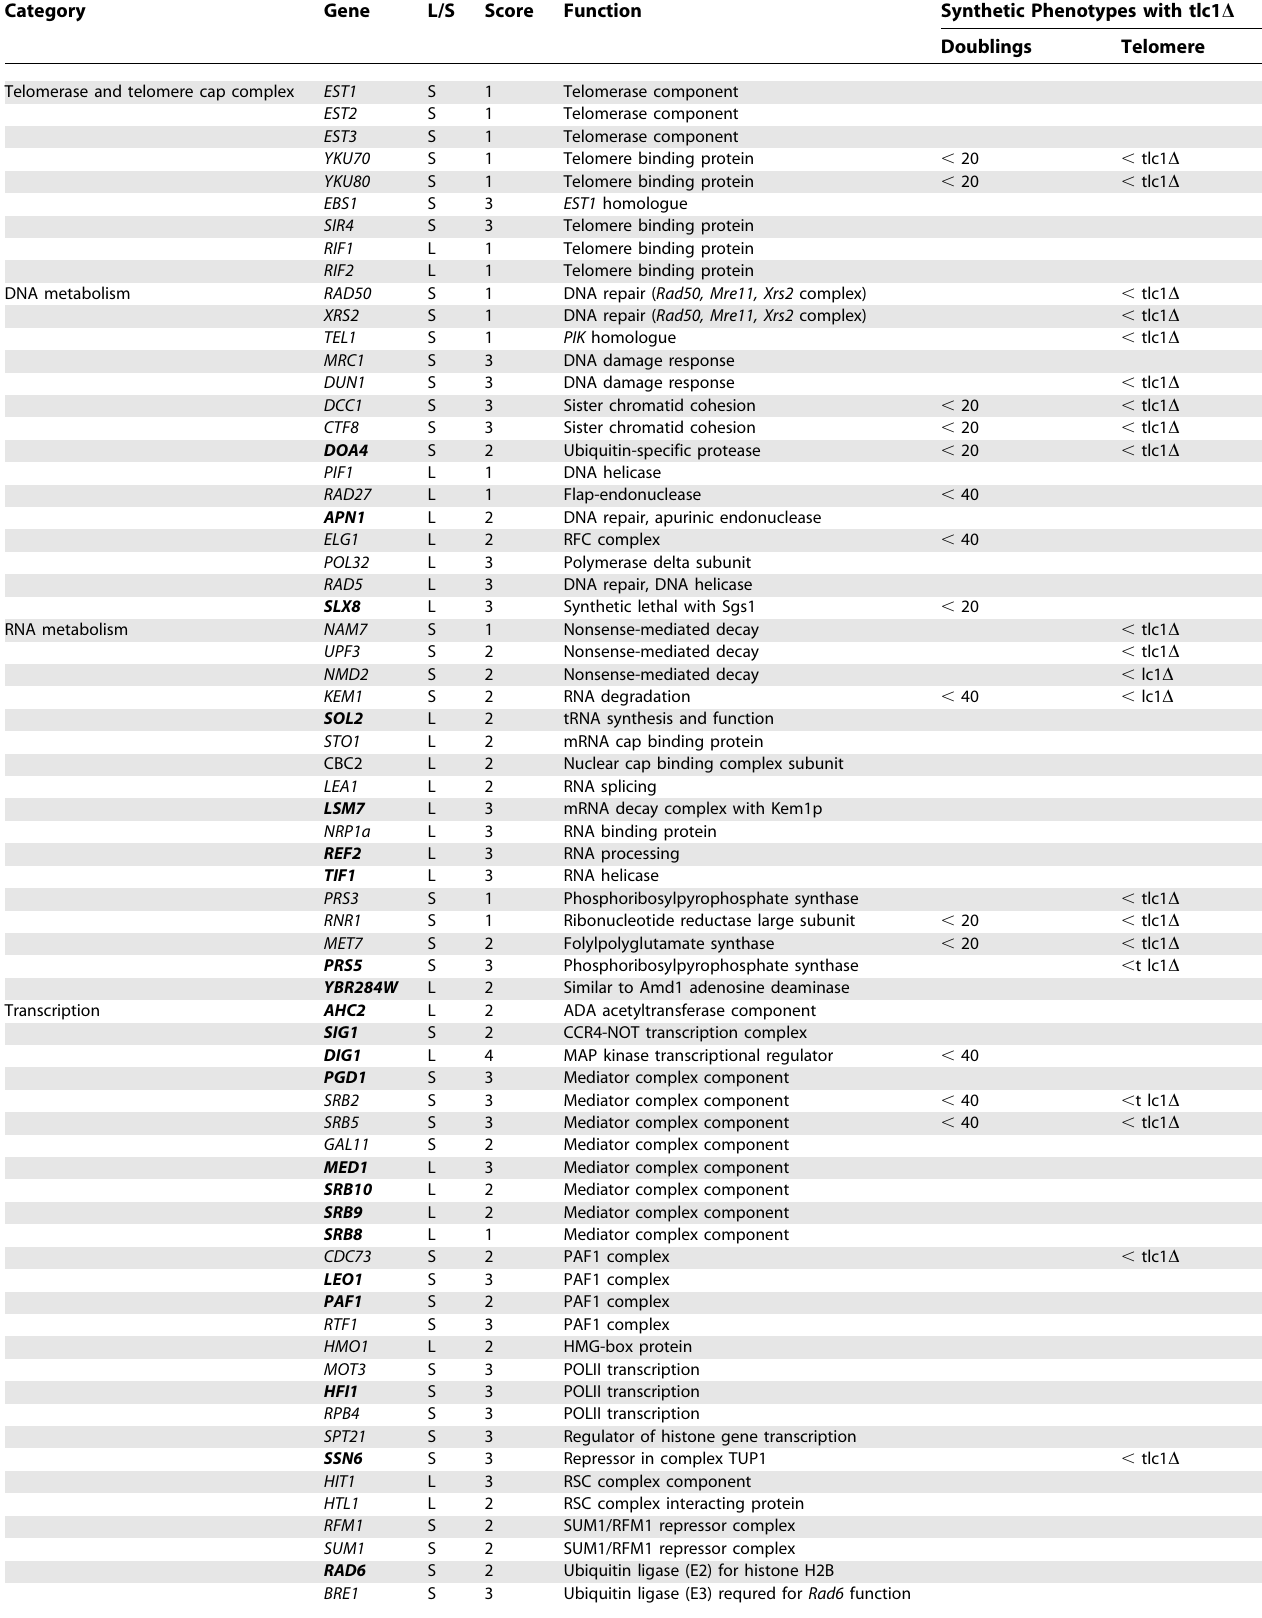
Table 1. Genes Whose Deletion Affects Telomere Length and Their Interaction with Telomerase Pathway Category